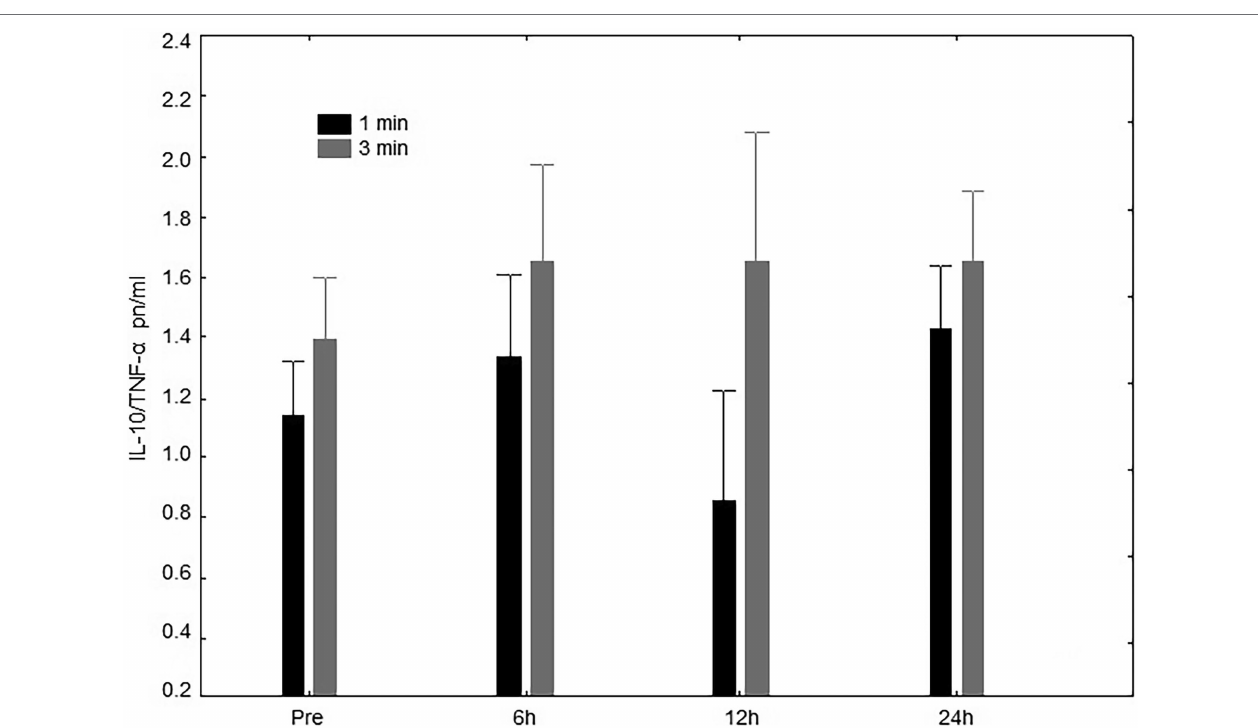
FIGURE 4 | IL-10/TNF- α pn/ml Interleukin-10 and tumoral necrosis factor- α ratio (IL-10/TNF- α ) concentrations at pre-exercise (Pre), 3, 6, 12, and 24 h after completing five sets of bench press and leg press exercises with 1- or 3-min of rest between sets.